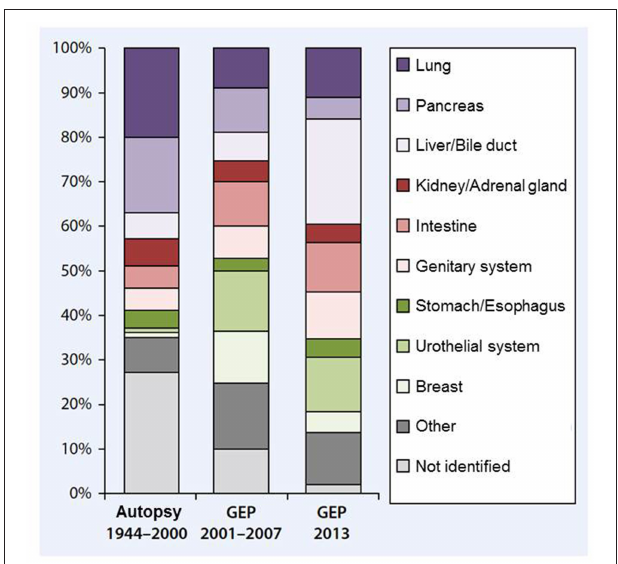
FIGURE 1 | displays the relative frequencies of (presumed) primary sites in CUP cancers. Pooled data from 12 autopsy studies including 844 autopsies from 1944-2000 (left) are juxtaposed to gene expression profiling data from more than 500 patients drawn from four studies published from 2001 to 2007 (middle) and 252 patients published in 2013 (right), drawn from Loffler et al. ( 18), previously adapted from (9, 19). Unfortunately, no autopsy and molecular data are available from the same decade, so the discrepant putative primary frequencies between the autopsy and the molecular studies might either reflect inconsistencies between both approaches or alternatively a bias by time